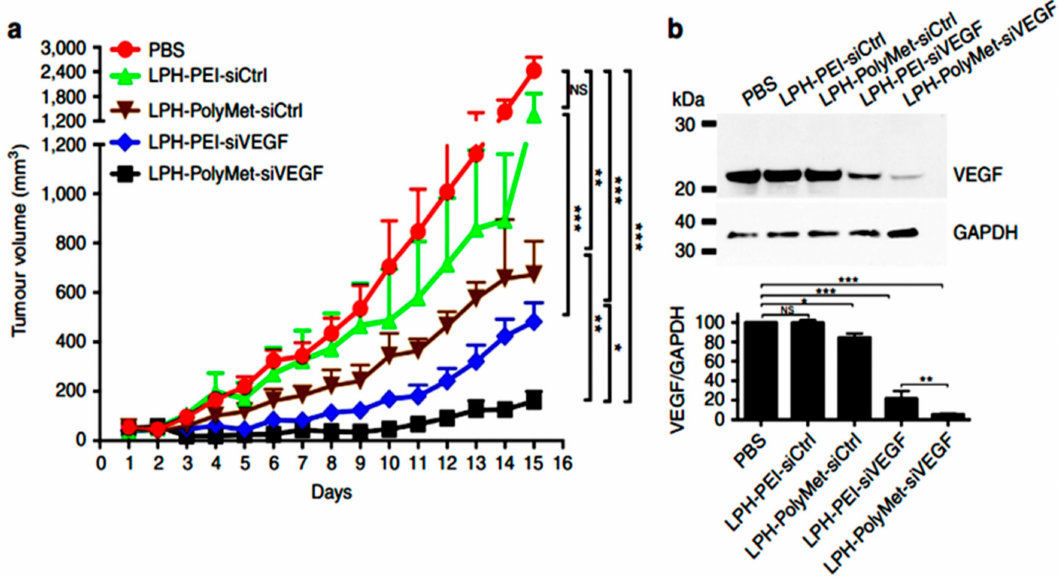
Figure 3. Lipid nanoparticles made up of PolyMet can systemically deliver vascular endothelial growth factor (VEGF)siRNA to the tumor site and inhibit tumor growth. ( a ) H460 tumor-bearing mice were injected i.v. every other day and tumor volumes were measured every day. ( b ) H460 tumor VEGF protein levels after two injections were measured by Western blot analysis. The bar chart in (b) represents the quantitative analysis of relative normalized VEGF band intensity (Image J). Data are mean ± s.e.m. (n 1 5 per group) analyzed by two-way analysis of variance with Tukey’s correction. 4 Data are representative of (b) or combined from (a) three independent experiments. NS, not significant; * p < 0.05, ** p < 0.01, *** p < 0.005. Reproduced with permission from [74]. Copyright, 2016,